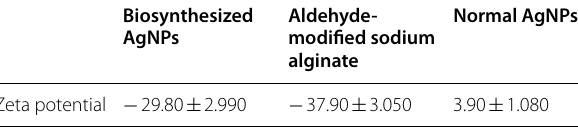
Biosynthesized AgNPs are silver nanoparticles synthesized by aldehyde- modified sodium alginate. Normal AgNPs are silver nanoparticles synthesized by chemical synthesis methods (no surfactant)